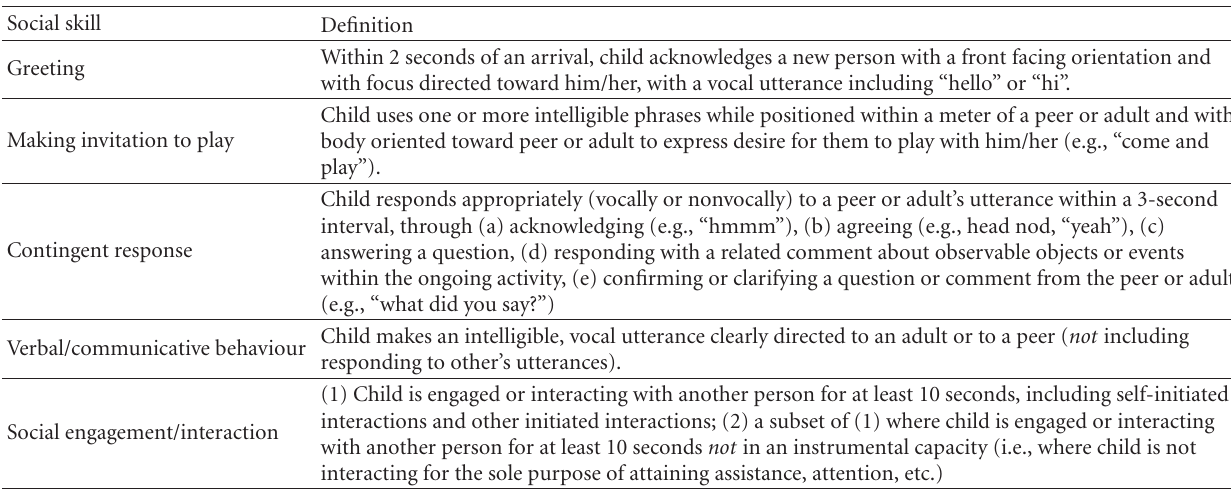
Table 1: Definitions of Dependant